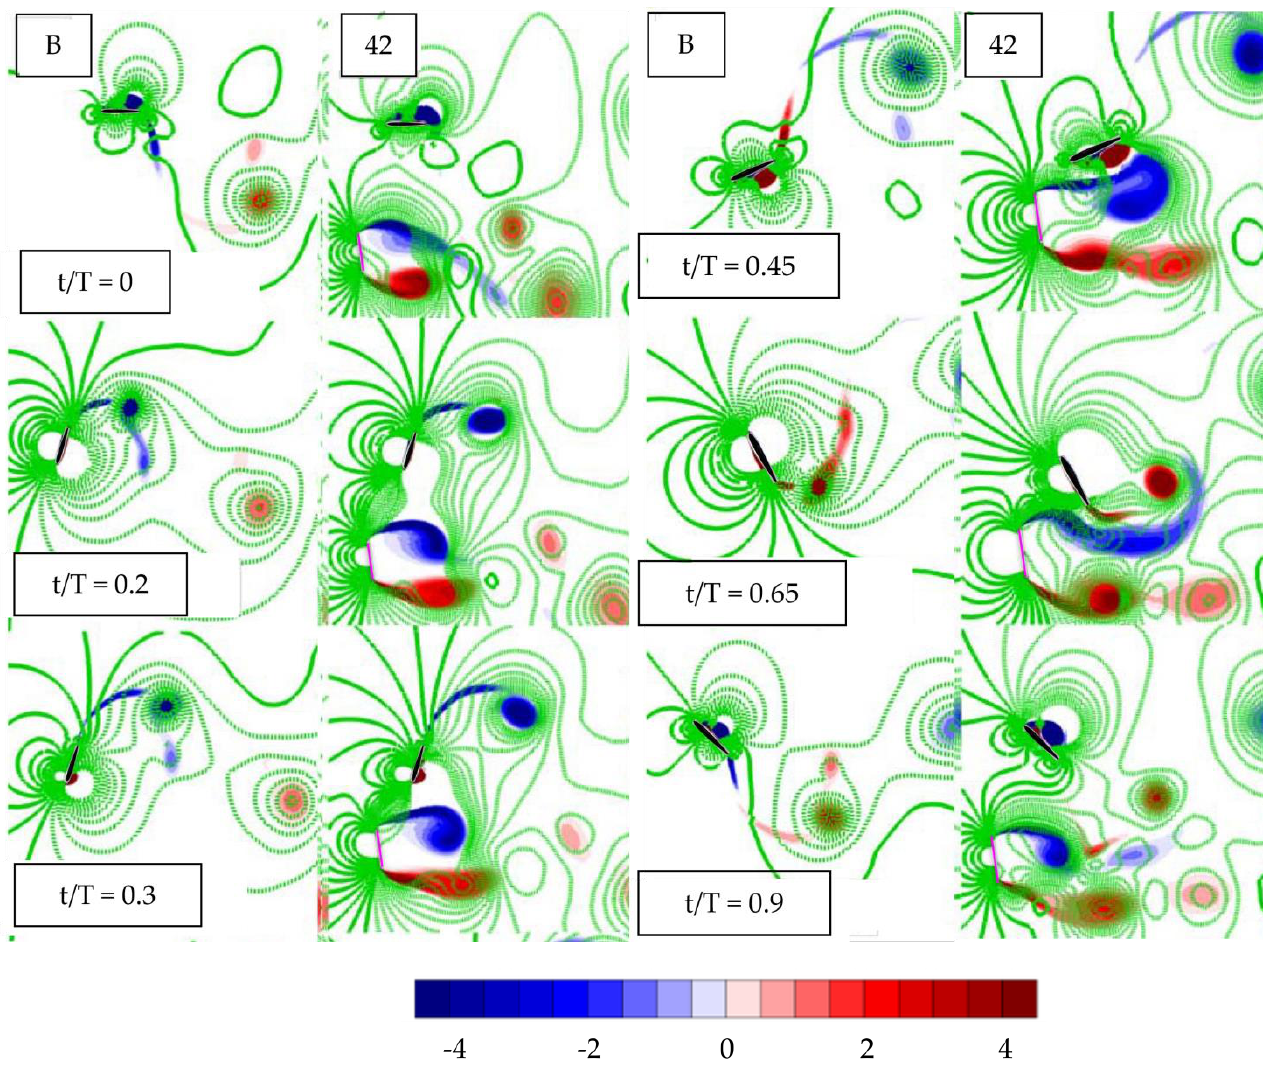
Figure 6. A comparison of the vortex structures and surface pressure distribution between the upstream-deflector hydrofoil and the conventional hydrofoil (solid isolines: positive pressure; dashed isolines: negative pressure).